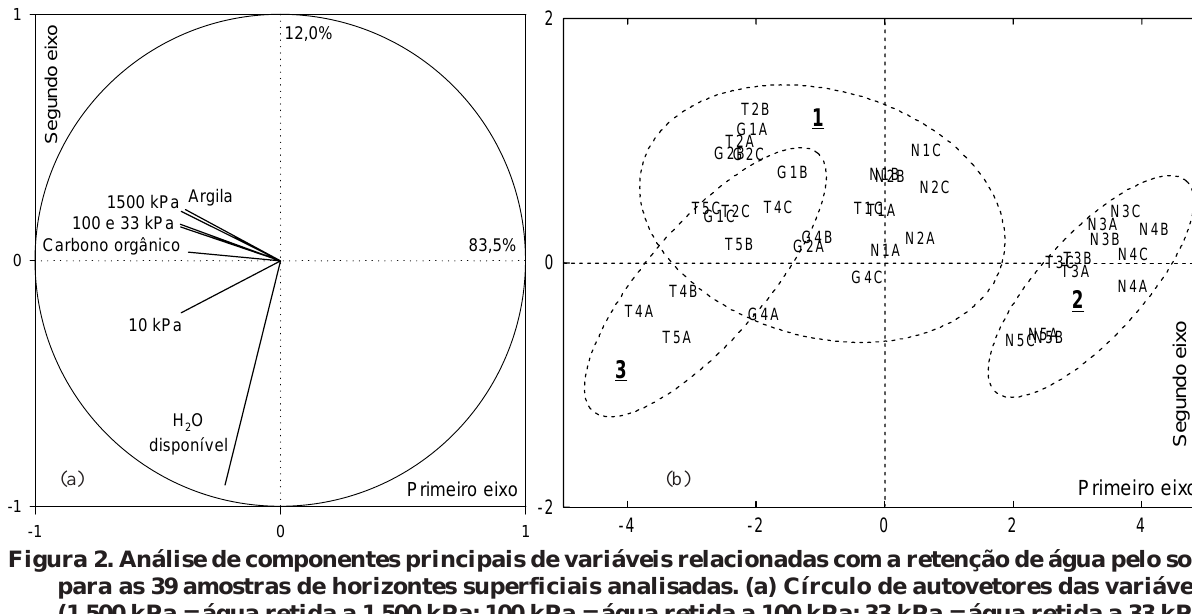
Figura 2. Análise de componentes principais de variáveis relacionadas com a retenção de água pelo solo para as 39 amostras de horizontes superficiais analisadas. (a) Círculo de autovetores das